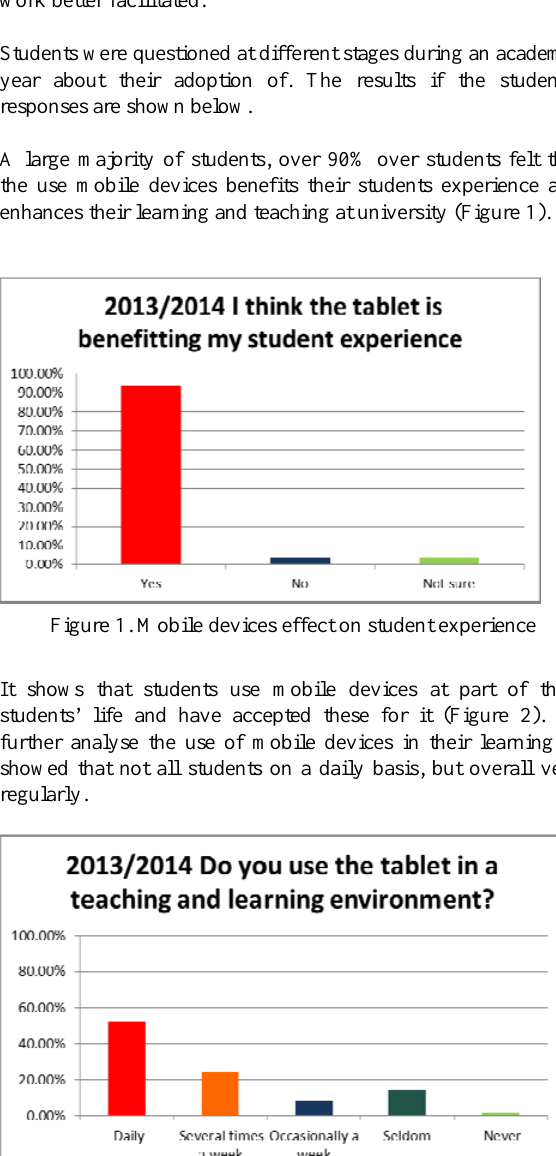
Figure 2. Use of mobile devices by students About 15% of the students had not taken to mobile devices and were using them rarely for their learning.